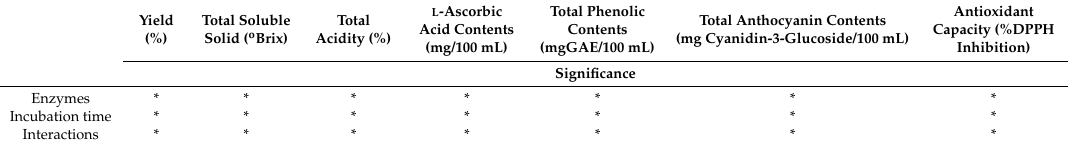
Table 2. Results of two-way ANOVA for the different analytical parameters measured in mulberry juice. Yield